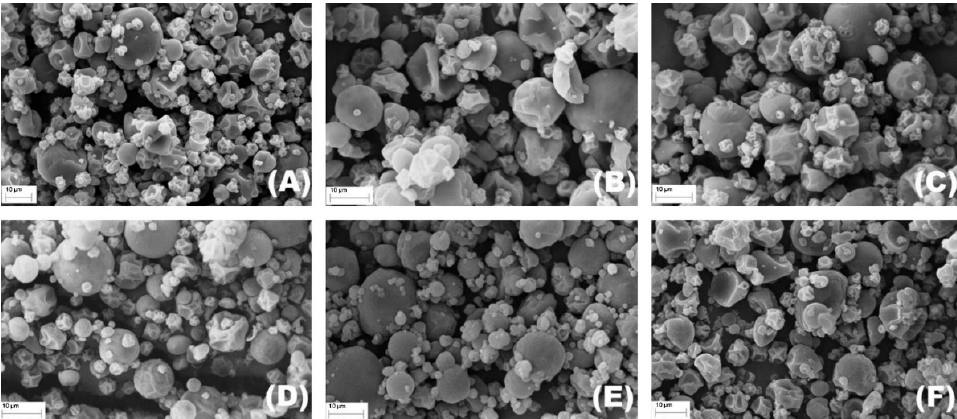
Figure 20. Scanning electron micrographs of the particles containing rosemary essential oil [203]. (A: arabic gum; B: arabic gum/maltodextrin; C: arabic gum/inulin; D: starch; E: modified starch/maltodextrin; F: modified starch/inulin).